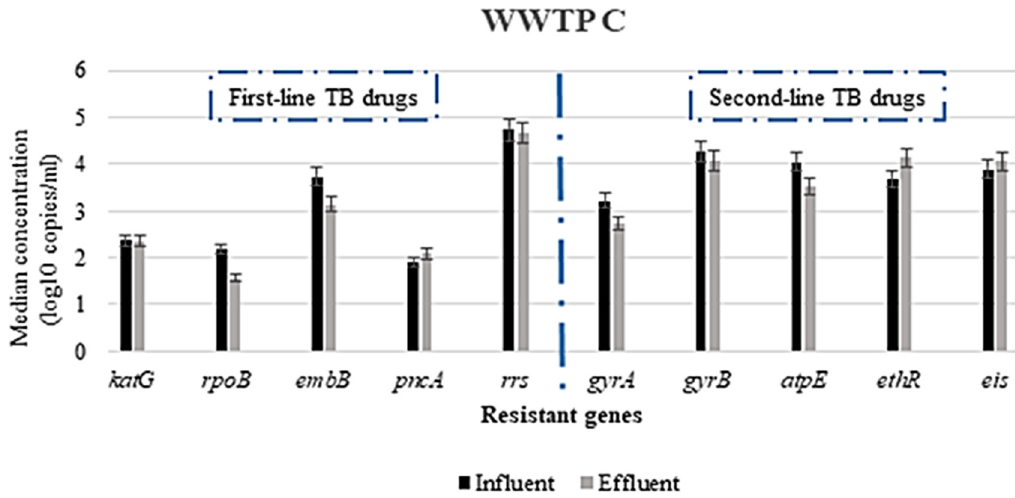
Figure 3. Median log copies/mL concentration of selected antimicrobial resistance genes in WWTP C.